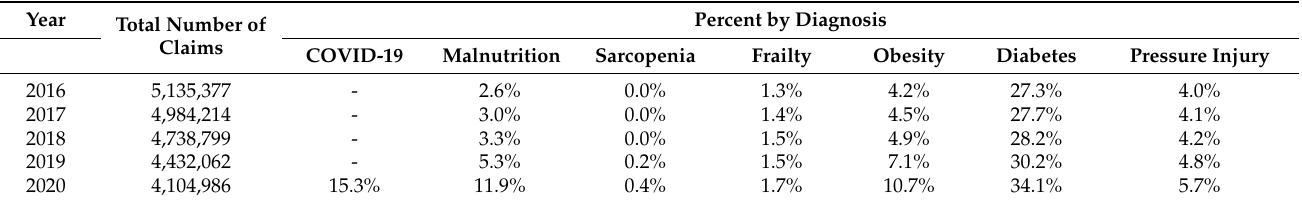
Table 2. Percentage of diagnosed conditions by year for the skilled nursing facility US Medicare claim set of specific diagnoses * (n =